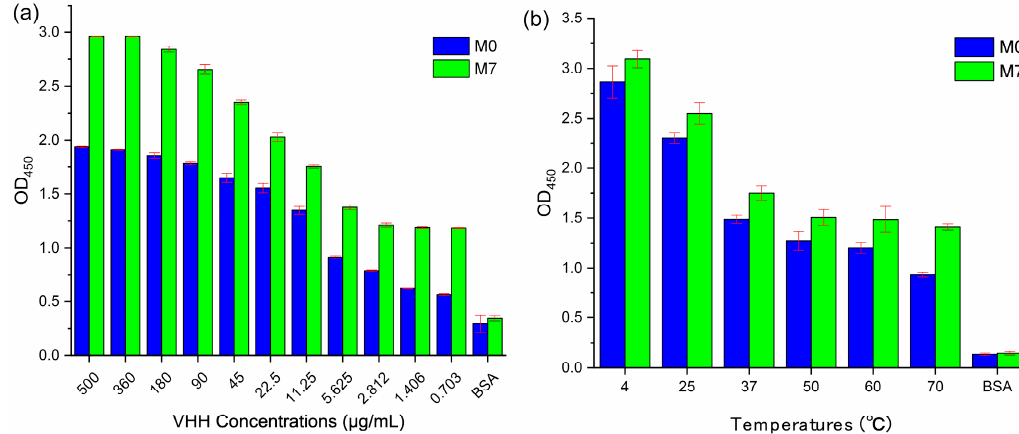
Figure 7. Indirect-ELISA of M0 and M7 targeting CD47 ext . ( a ) M0/M7 were serially diluted and tested for binding to wells coated with CD47 ext antigen. ( b ) M0/M7 were treated 10 min in six different temperatures and added to wells coated with CD47 ext antigen. Bound VHHs were detected with an HRP-conjugated anti-His tag mAb, and the optical densities (OD) at 450 nm were measured by Tecan Infinite M Nano+. All samples repeated in triplicate, and values are shown as mean ± SD.